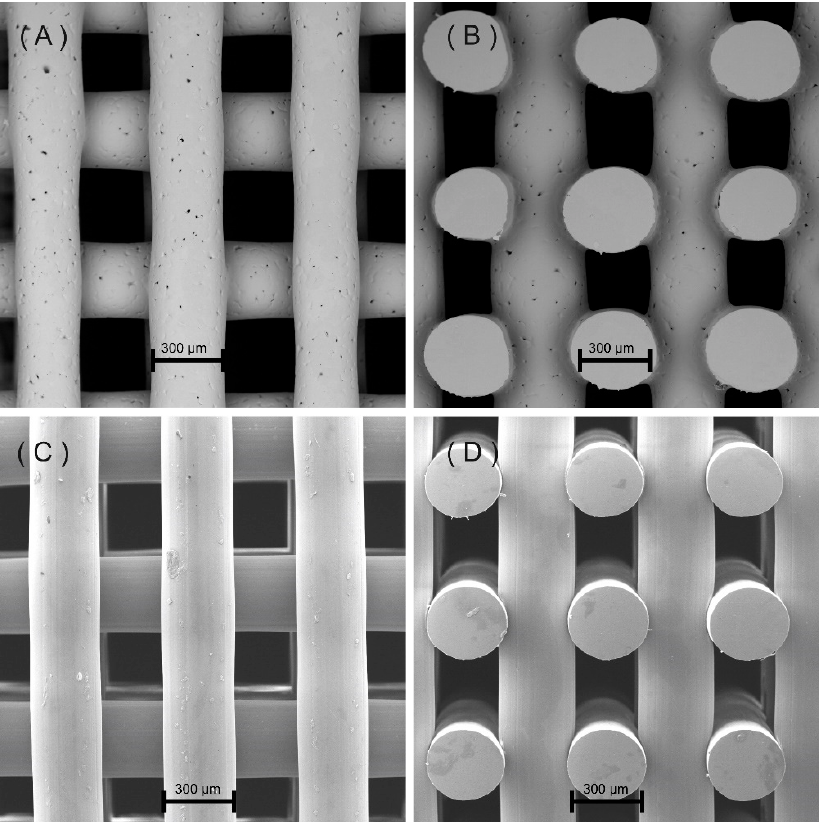
Figure 2. ( A ) Top view of a polycaprolactone (PCL) scaffold, ( B ) cross-section view of a PCL scaffold, ( C ) top view of a Polyethylene terephthalate glycol modified (PETG) scaffold, ( D ) cross-section view of a Polyethylene terephthalate glycol modified (PETG) scaffold. All scaffolds were designed considering a pore size of 350 µ